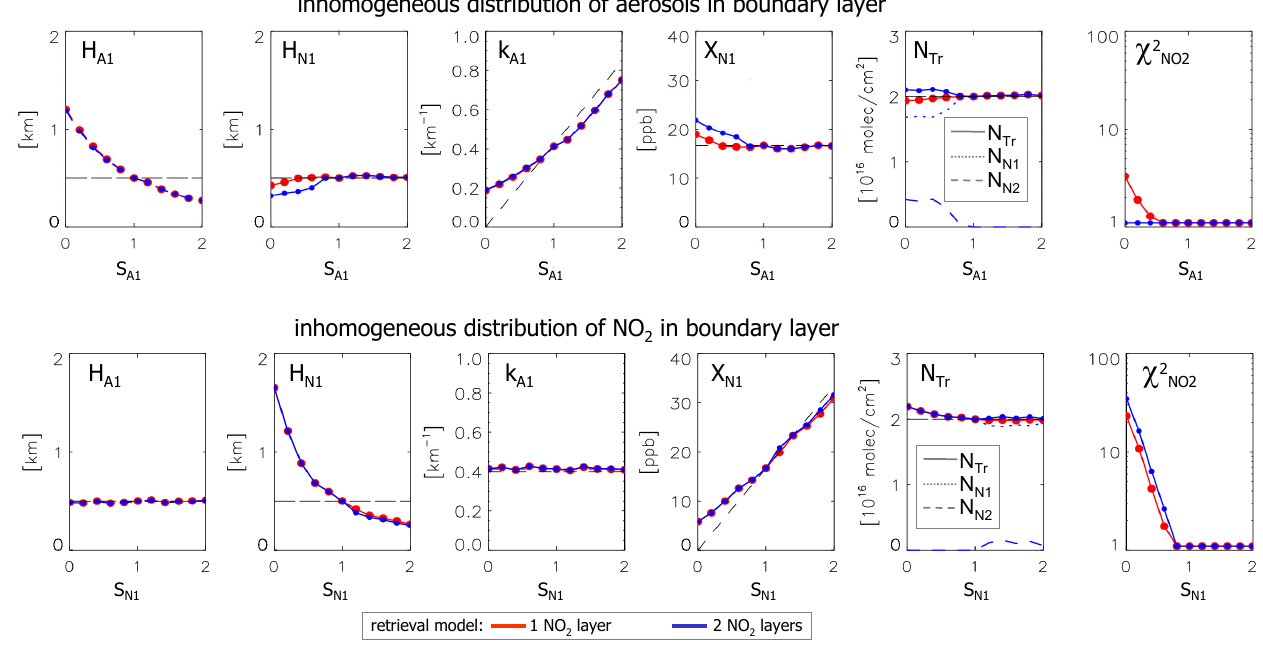
Fig. 8. Sensitivity study C (top row) and D (bottom row): inhomogeneous boundary layer distributions of aerosols and NO 2 . The black dashed lines indicate prescribed values in the sensitivity study, i.e. the truth in the simulation. The aerosol retrieval was performed with the single aerosol layer retrieval